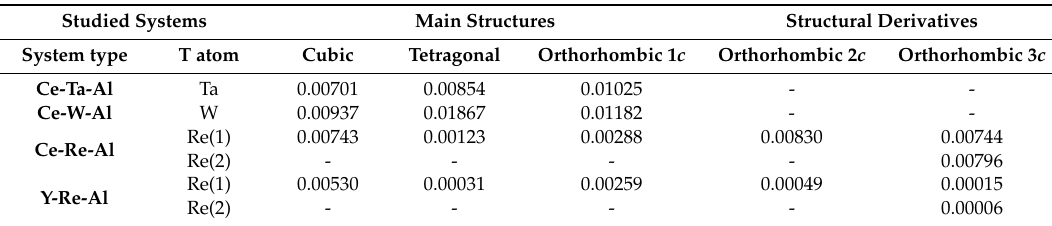
Table 5. Magnetic moment (in µ B) of the transition metal in the considered structures in the CeT 2 Al 20 (T = Ta, W, Re) and YRe 2 Al 20